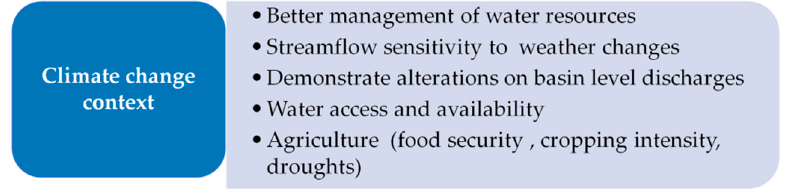
Figure 6. Applications considering a climate context.